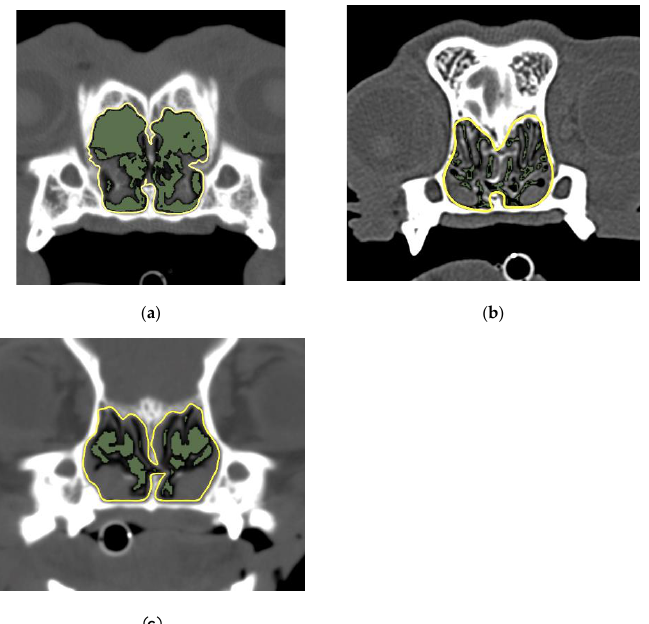
Figure 4. Image of suborbital foramen level and the AA/NC ratios for three dog breeds. ( a ) French bulldog; ( b ) shih tzu; ( c ) pug. The AA/NC ratio was the highest in French bulldogs (55.54%). The following are the typical images and measurements. There were no clear differences between shih tzus (21.03%) and pugs (21.47%). AA/NC, airway cross-sectional area/total nasal cavity area. Moreover, French bulldogs and pugs showed a tendency for the AA/NC ratio to in- crease from the rostral to the caudal direction. In contrast, the area ratio for the shih tzus was highest at the canine teeth level and lowest at the palatal horizontal plate level (Table 1). Table 1. Median AA/NC ratios in four planes (%).